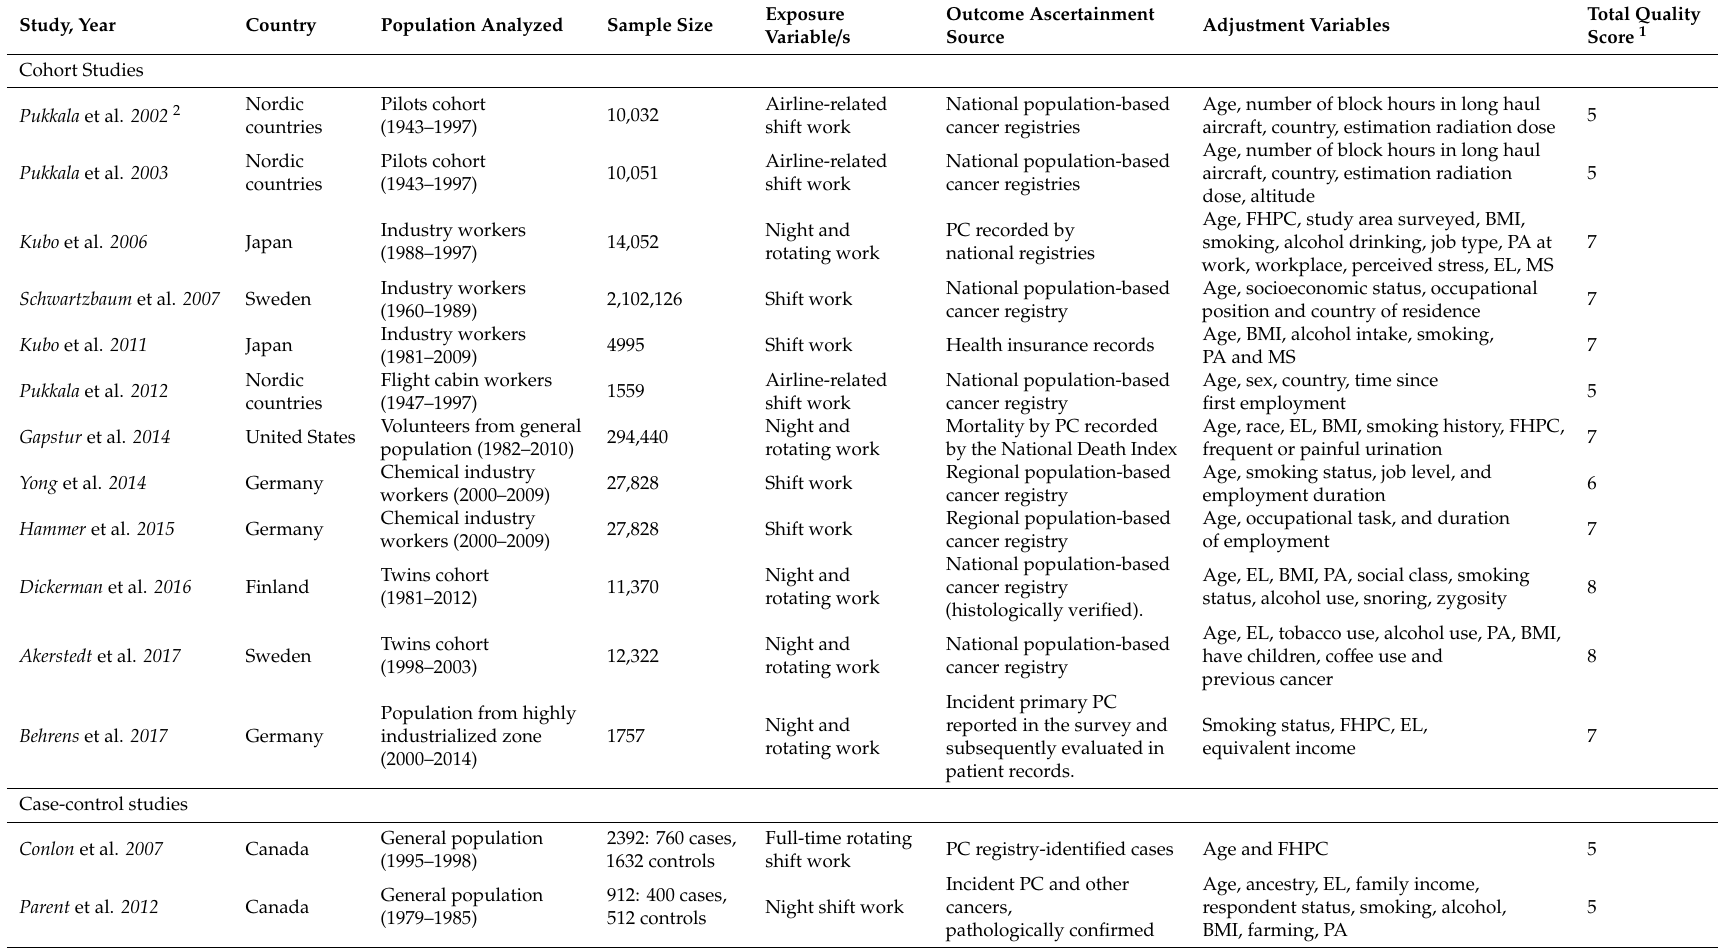
Table 1. Main characteristics of the selected